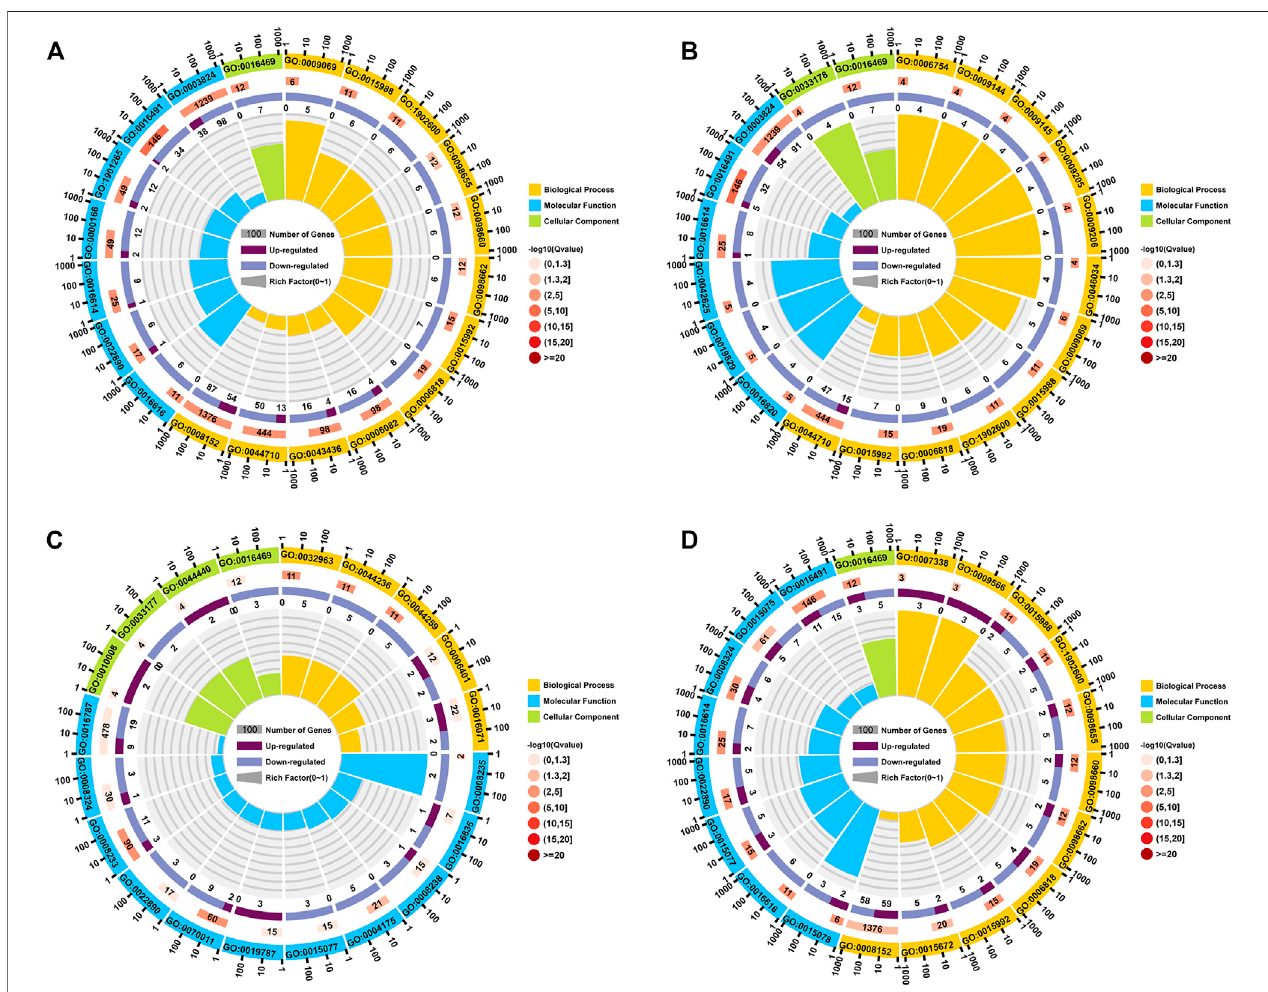
FIGURE3| CircleplotsshowingGOenrichmentofthegenesdifferentiallyexpressedbetweencold-tolerantandcommon Litopenaeusvannamei at10 ° Cand28 ° C. (A) Lv-C28-vs-Lv-C10 (common at 28 ° C versus common at 10 ° C), (B) Lv-T28-vs-Lv-T10 (cold-tolerant at 28 ° C versus cold-tolerant at 10 ° C), (C) Lv-C10-vs-Lv-T10 (commonat10 ° Cversuscold-tolerantat10 ° C),and (D) Lv-C28-vs-Lv-T28(commonat28 ° Cversuscold-tolerantat28 ° C).Theoutermostcircleofeachgraphshowsthe 20 GO terms most commonly signi fi cantly enriched in the differentially expressed genes (DEGs). The second circle shows the number of genes associated with eachGOterm;redderbarscorrespondtogreaterQ-values.ThethirdcircleshowstheratioofupregulatedtodownregulatedDEGsassociatedwitheachGOtermasbar graph, with upregulated genes shown in light purple and downregulated genes shown in dark purple; the speci fi c numbers of up- and downregulated genes are shown belowbar.Theinnermost(fourth)circleshowstheRichFactorvalueforeachGOterm(i.e.,thenumberofDEGsversusthenumberofnon-DEGsassociatedwiththeGO term); each gridline represents